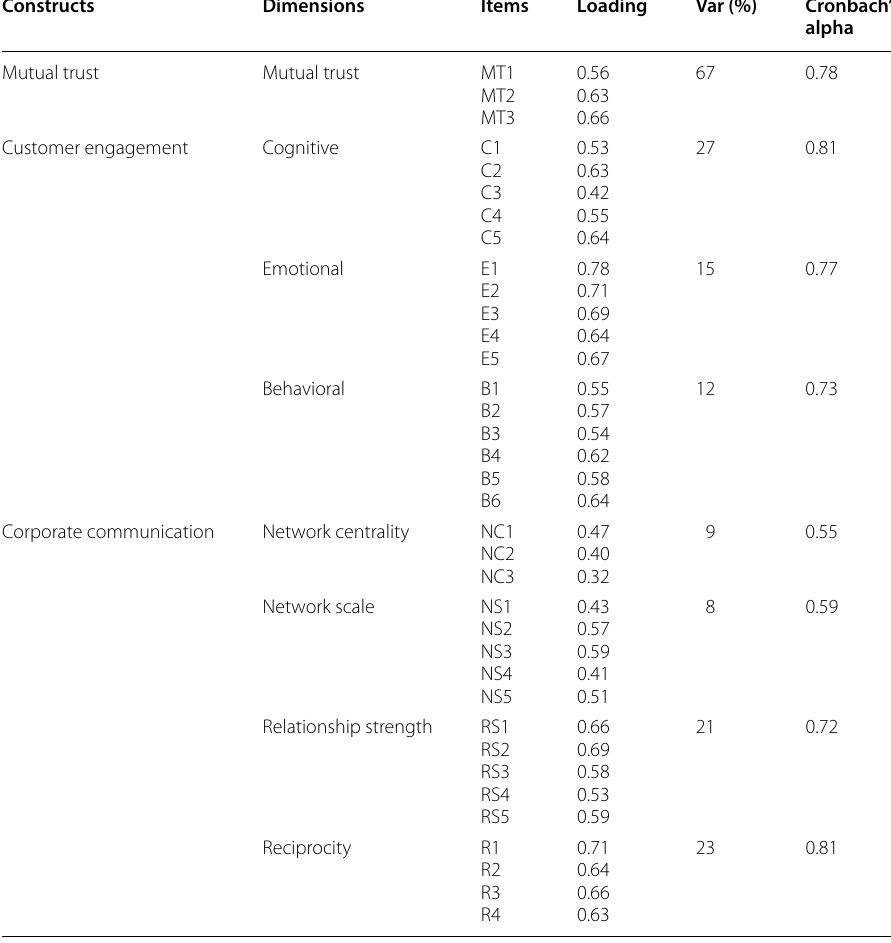
Table 3 Component analysis